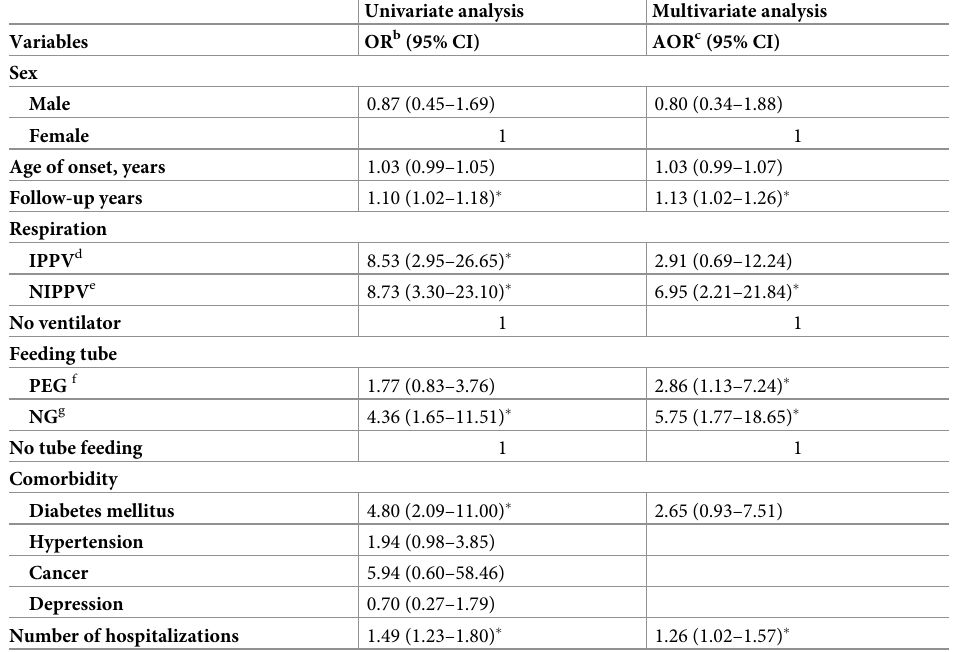
Table 2. Univariate and multivariate analysis of factors associated with DNR a among patients with amyotrophic lateral